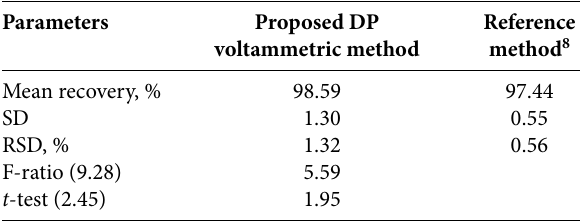
Table 4. Statistical comparison between the results of Myoflex tab- lets using the proposed DP voltammetric method and the reference method.